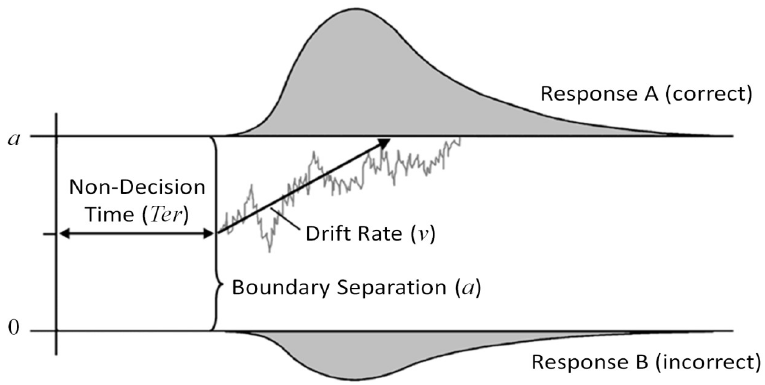
Figure 1. Diffusion model for binary decision tasks.